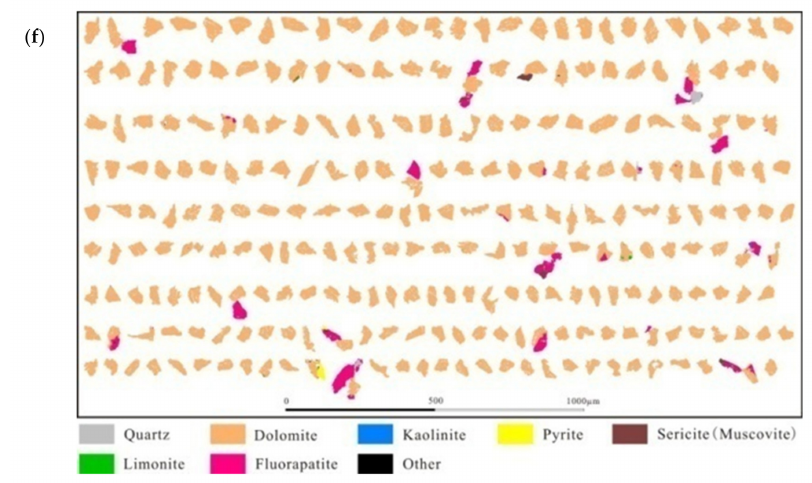
Figure 12. Intergrowth relationship between each gangue mineral and other minerals (particle size of 38–75 µ m): ( a ) quartz, ( b ) sericite (muscovite), ( c ) kaolinite, ( d ) pyrite, ( e ) limonite, and ( f )